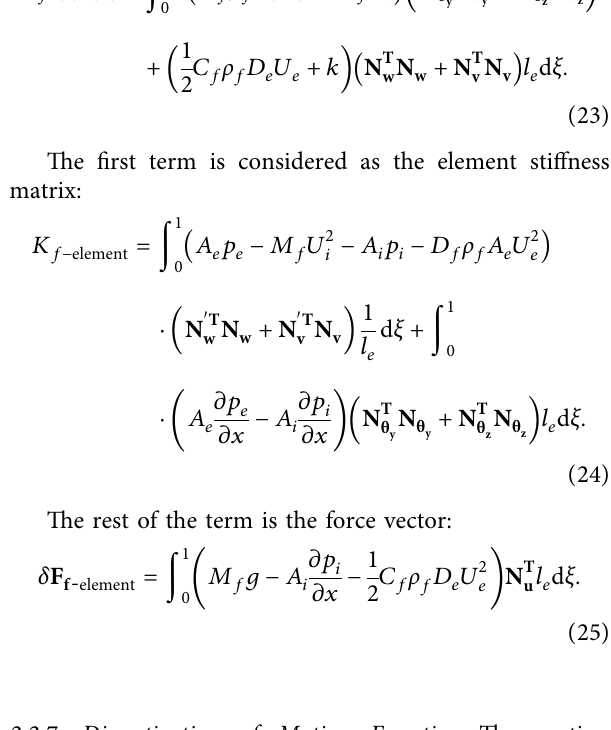
Figure 5: Internal flow